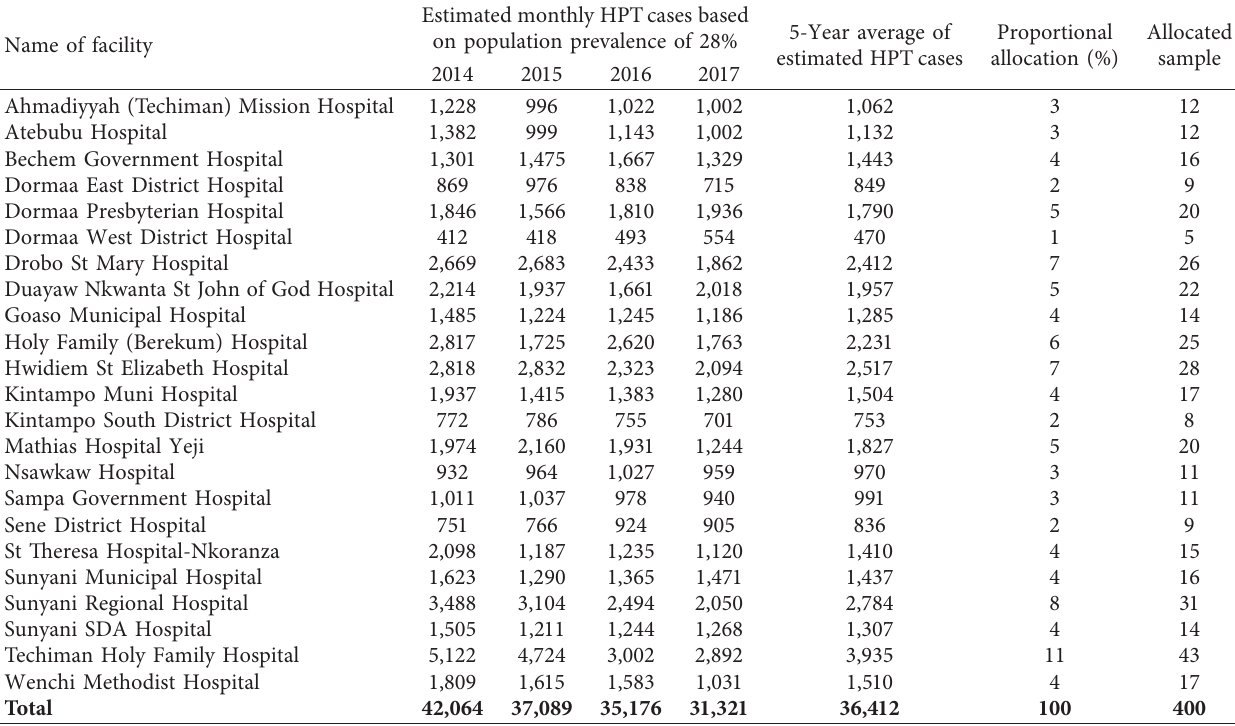
Table 1: Allocation of the sample to health